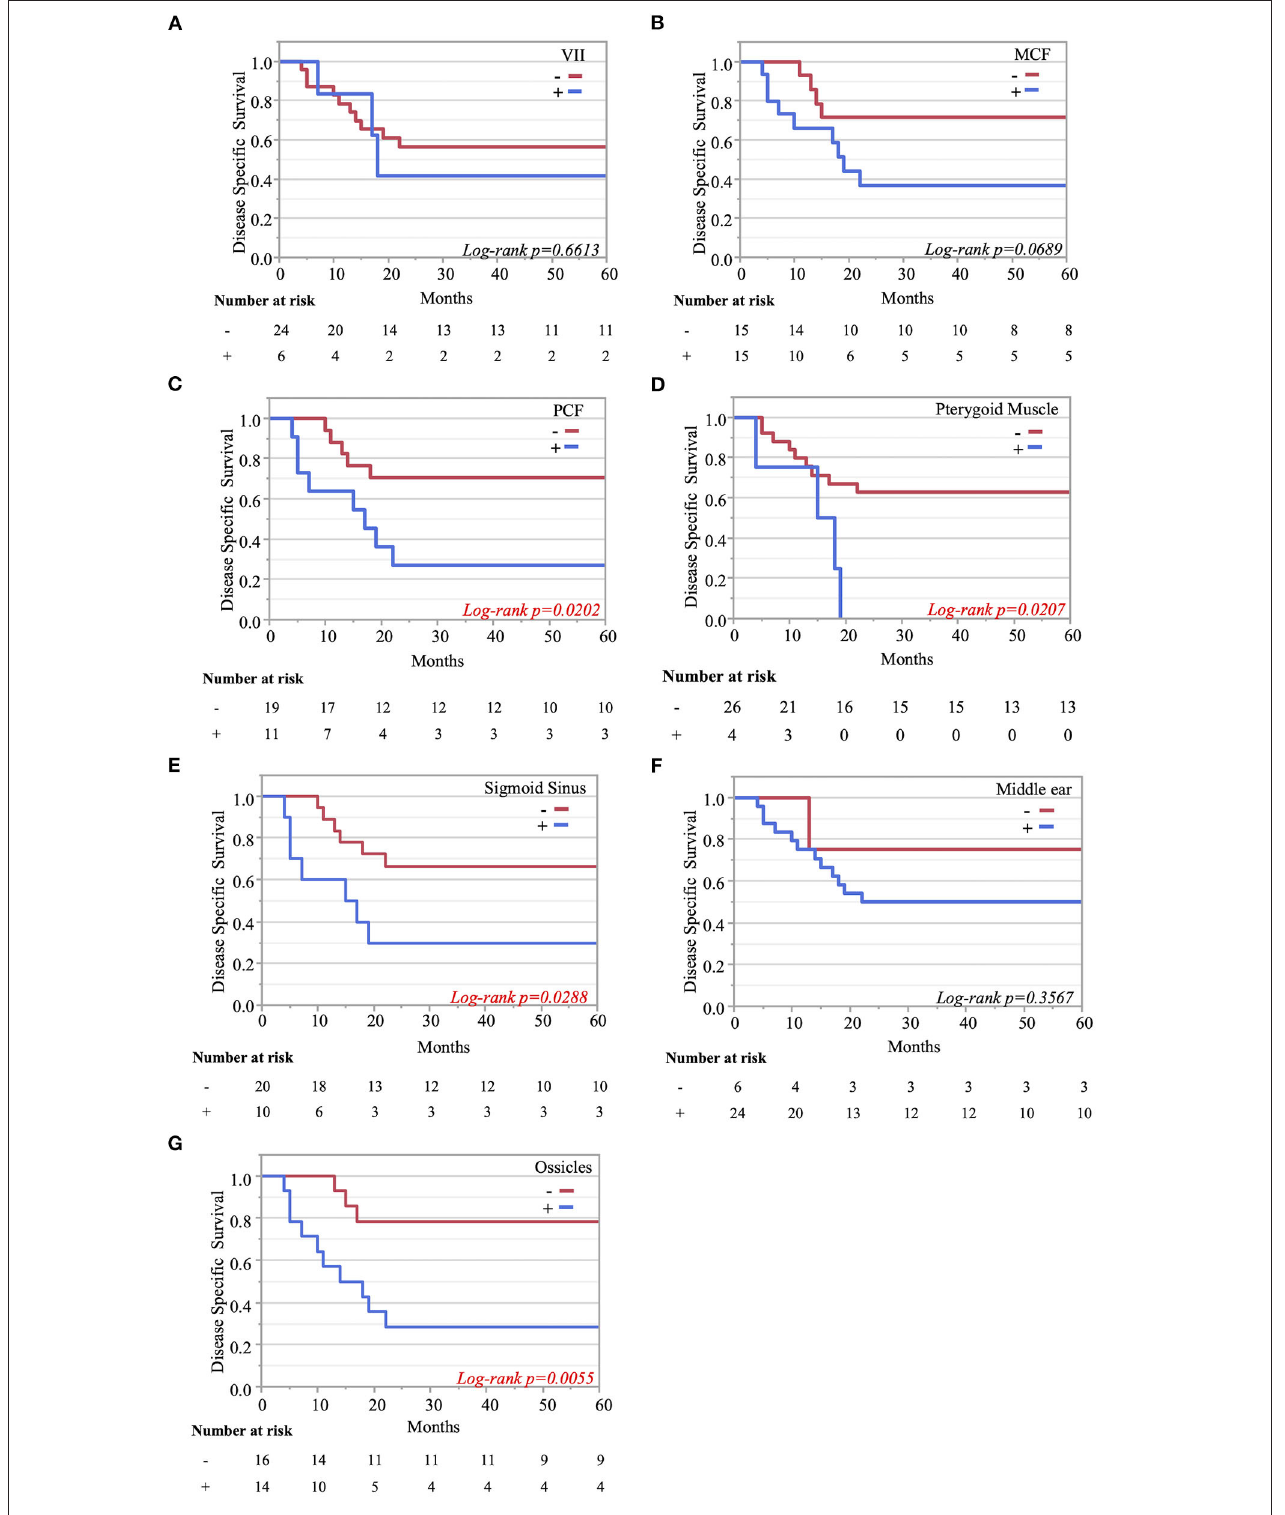
FIGURE 4 | Kaplan–Meier curves. Disease-specific 5-years survival curves according to tumor invasion of the facial nerve (A) , middle cranial fossa (B) , posterior cranial fossa (C) , pterygoid muscle (D) , sigmoid sinus (E) , middle ear (F) , and ossicle destruction (G) .